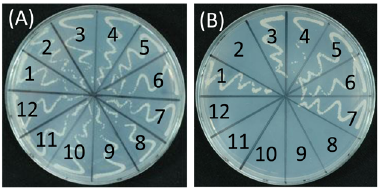
Figure 2. Amino acid substitution in Domain IV of Osiaa23 prevents the protein-protein interactions between Osiaa23 and OsARFs. Interactions between Osiaa23 and OsARFs, Osiaa23-R5 and OsARFs in the yeast two-hybrid system. 1, positive control; 2, negative control; 3, Osiaa23 + OsARF6; 4, Osiaa23 + OsARF12; 5, Osiss23 + OsARF16; 6, Osiaa23 + OsARF17; 7, Osiaa23 + OsARF25; 8, Osiaa23-R5 + OsARF6; 9, Osiaa23-R5 + OsARF12; 10, Osiaa23-R5 + OsARF16; 11, Osiaa23-R5 + OsARF17; 12, Osiaa23-R5 + OsARF25. Yeast was grown on medium without leucine and tryptophan (SD -Leu/ -Trp) as a contral (A) and medium without leucine, tryptophan, histidine and ade (SD -Trp/ - Leu/ -Ade/ -His) to test the protein-protein interactions (B).